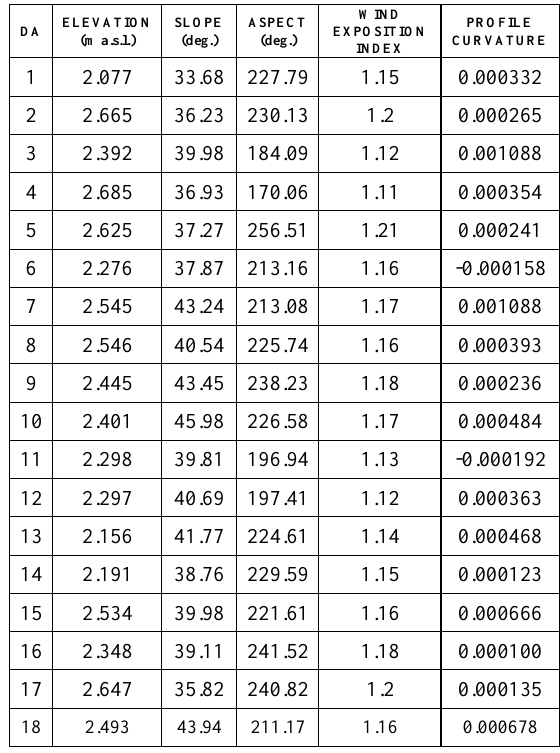
Table 1. Statistics of geomorphological parameters of avalanche detachment areas (DA). Mean values are reported.